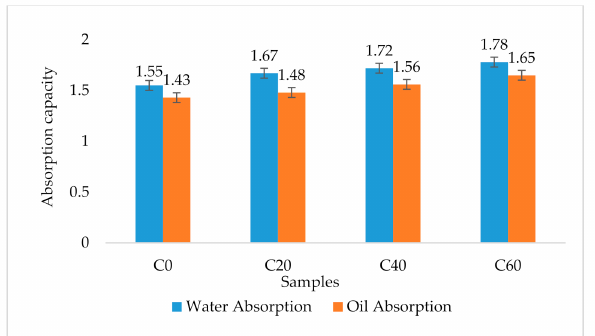
Figure 2. Water and oil absorption capacity of cookie flours. Water absorption is expressed as g water / g flour. Oil absorption is expressed as g oil / g flour. Error bar values are actual values obtained. C0: control (100% wheat cookies); C20: 15% sorghum and 5% termite substitution level; C40: 30% sorghum and 10% termite substitution level; C60: 45% sorghum and 15% termite substitution